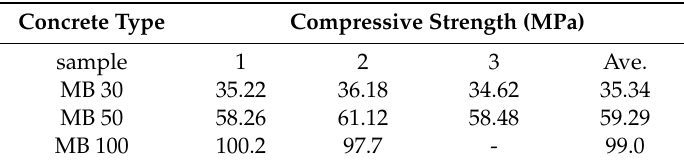
Table 4. Compressive and indirect tensile strength for concrete types MB 30 and MB 50 after 28 days.